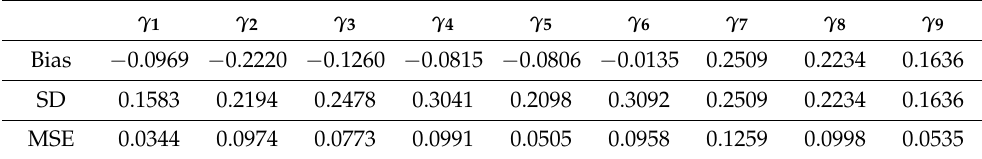
Table 11. Bias, SD and MSE evolutions with respect to the parameter γ variation for PLGSIMF with the logit link function and n = 1000.